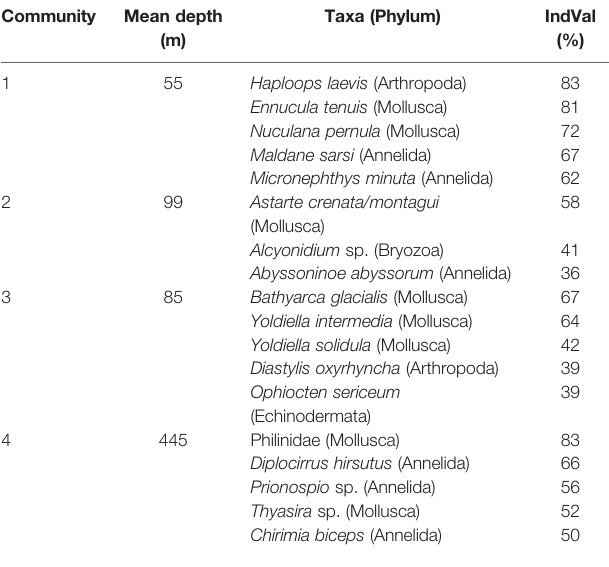
TABLE 2 | Indicator species (5 most important species are presented) of each benthic infaunal community in the Kitikmeot sea region and Parry Channel based on the IndVal